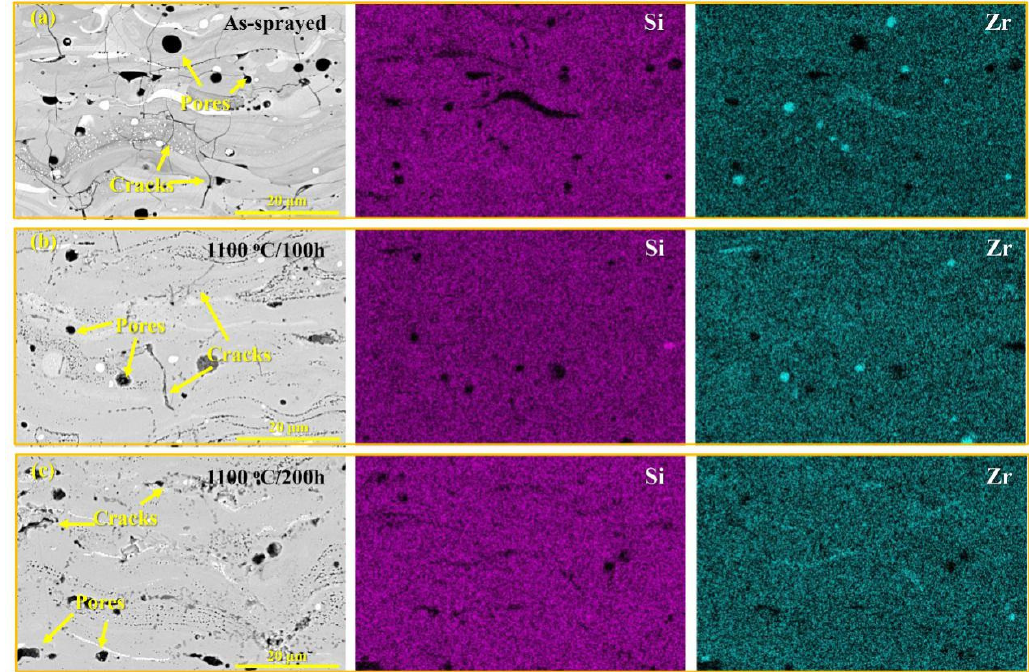
Figure 7. Cross-section morphologies with EDS results of as-sprayed ( a ), 100h ( b ) and 200h ( c ) of the CZSO coatings aged at 1100 °C.